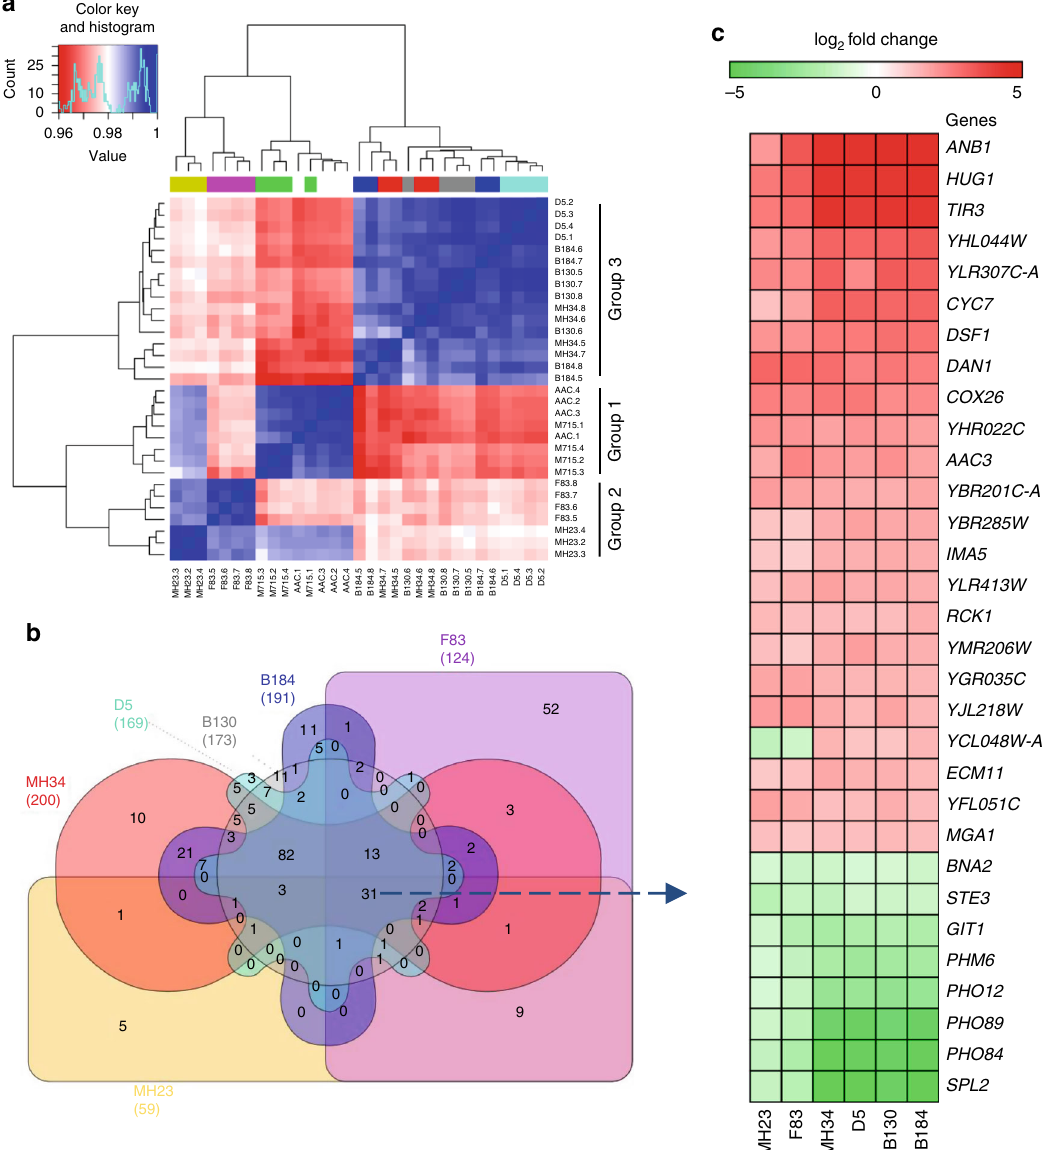
Fig. 2 Overview of transcriptome data. a Heatmap of Spearman ’ s correlation coef fi cient for the similarities in the expression pro fi les of exponential phase between the different samples by pairwise comparison. b Common very signi fi cantly differentially expressed genes ( P -adj < 0.05 (Benjamini – Hochberg method) and abs (log 2 Fold change) > 1) in the mutant strains compared with the reference strain AAC. The number of very signi fi cantly differentially expressed genes in each strain is speci fi ed under the strain name. c Expression levels of common signi fi cantly differentially expressed genes in mutant